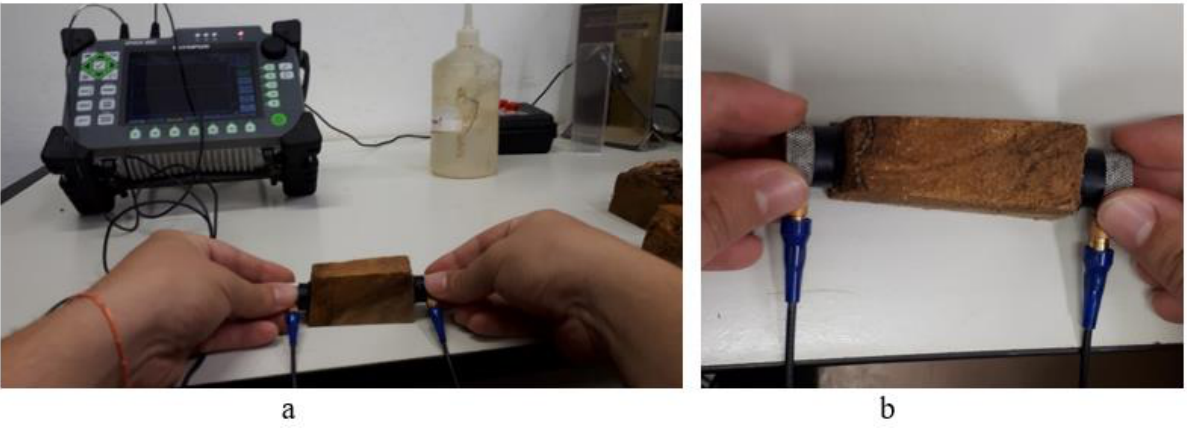
Figure 5. Example of ultrasound trials performed on a prismatic specimen ( a ) and detailing the coupling of transducers to the specimen ( b ).